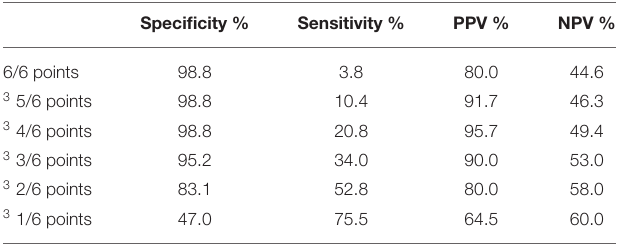
TABLE 4 | Specificity, sensitivity, PPV, and NPV of aBUS for different cut-off values. Specificity